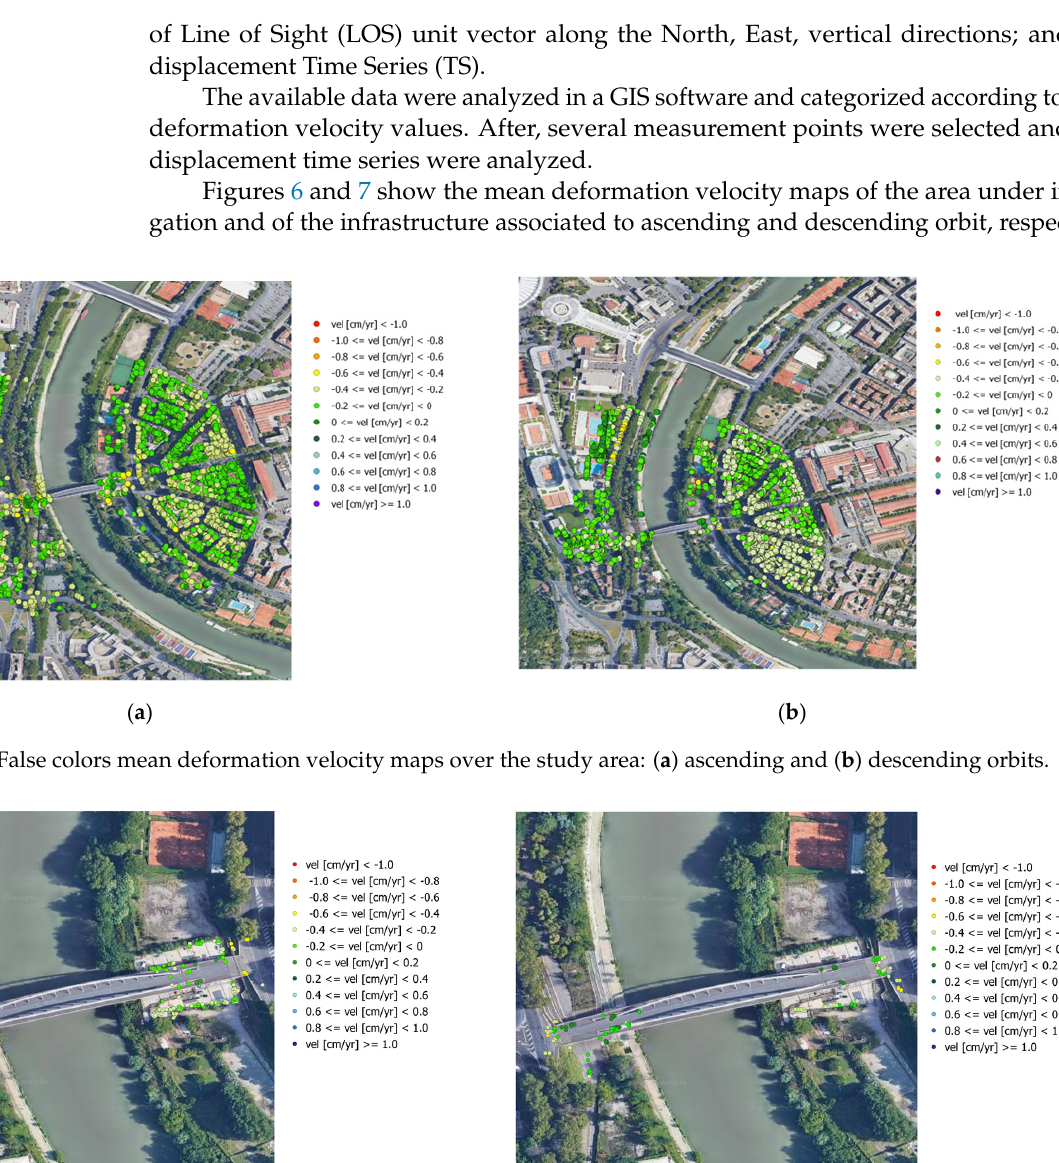
Figure 8. Displacement time ‐ series relating to the measure points located on the bridge abutments and foundation of the west (in blue) and east (in red) bank of the Tiber river — ascending orbit.